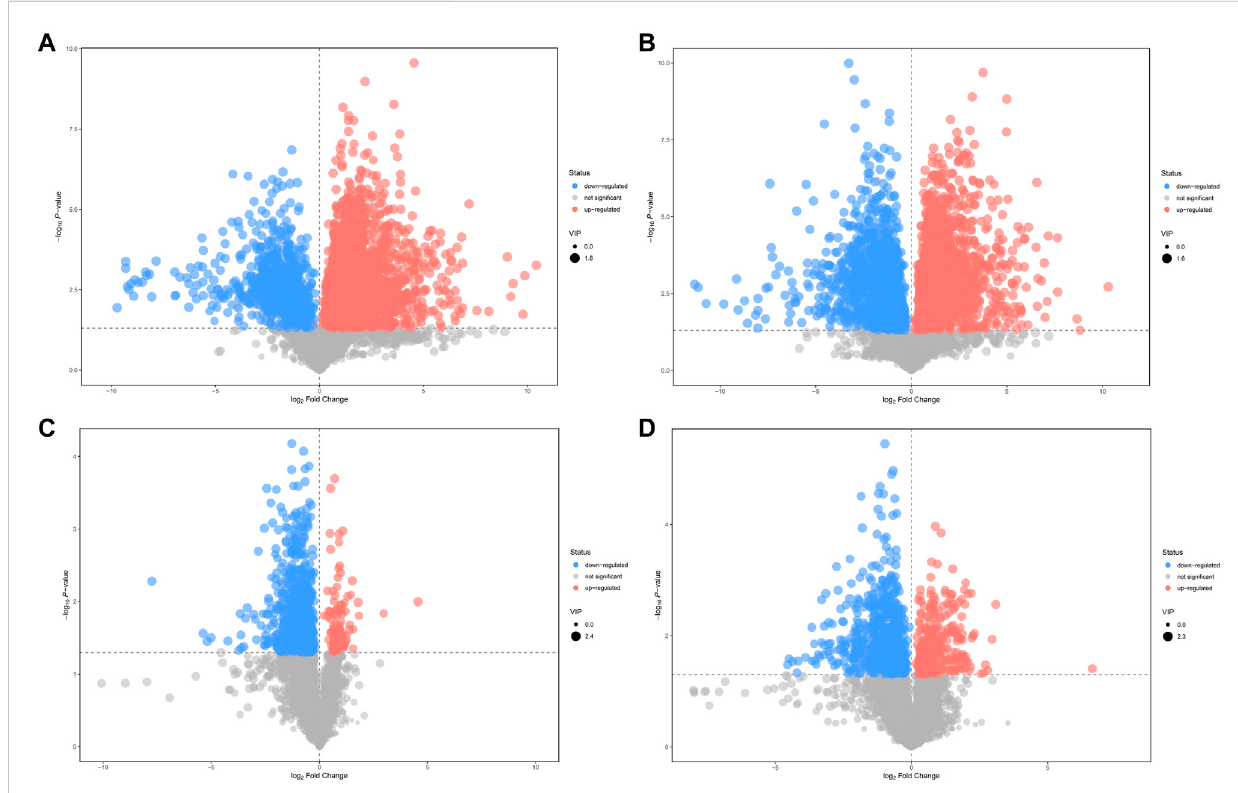
FIGURE 4 Volcano plots of differential metabolites. Comparison between N and M in positive (A) and negative (B) ion mode. Comparison between M and AMCZ in positive (C) and negative (D) ion